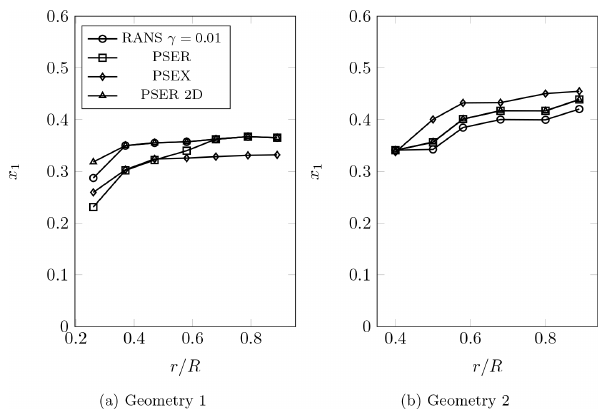
Figure 10. Transition